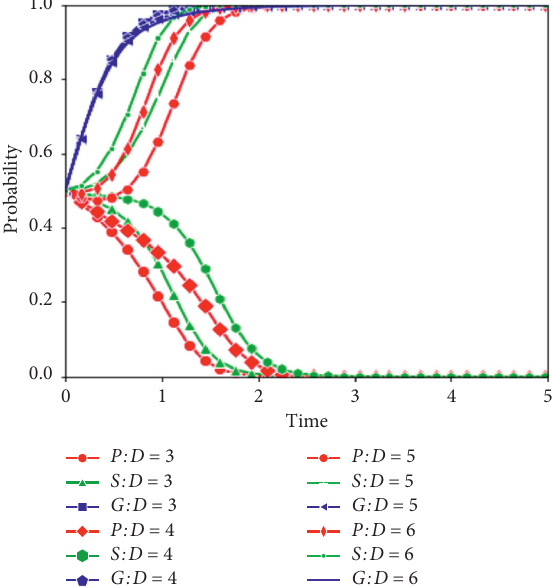
Figure 5: Dynamic evolution process of the tripartite game sub- jects when x and y change simultaneously.